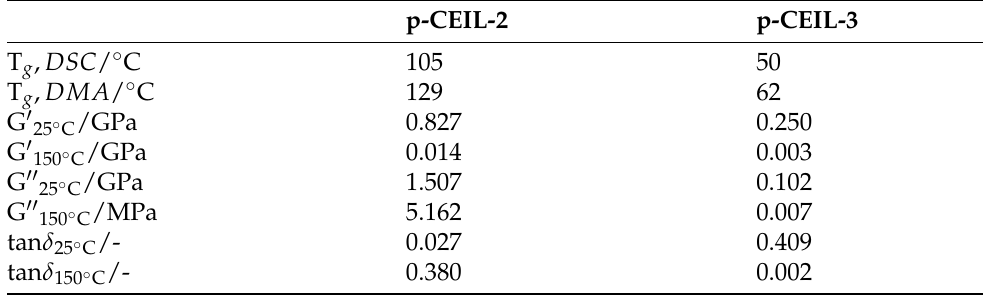
Table 3. Experimentally measured thermo–mechanical properties of the polymerised samples.